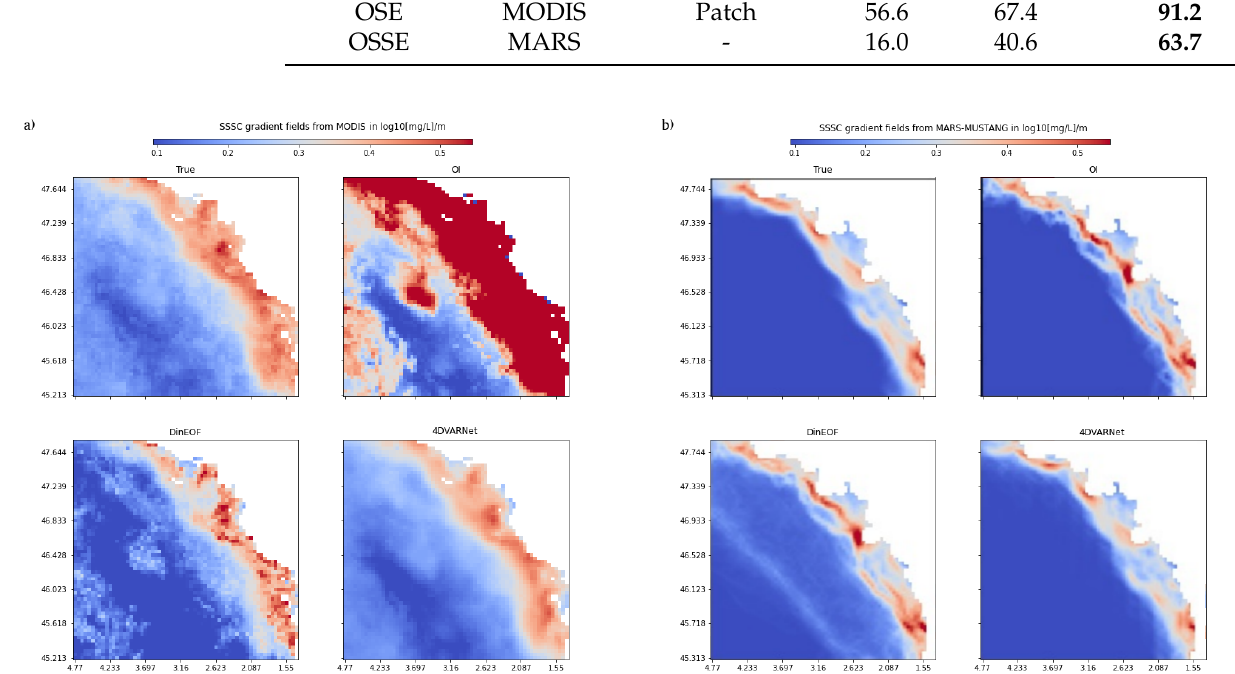
Figure 4. Reconstruction norm of SSSC gradient fields for the OSE (MODIS) and OSSE (MARS) application for the whole validation period: ( a ) OSE configuration ( b ) OSSE